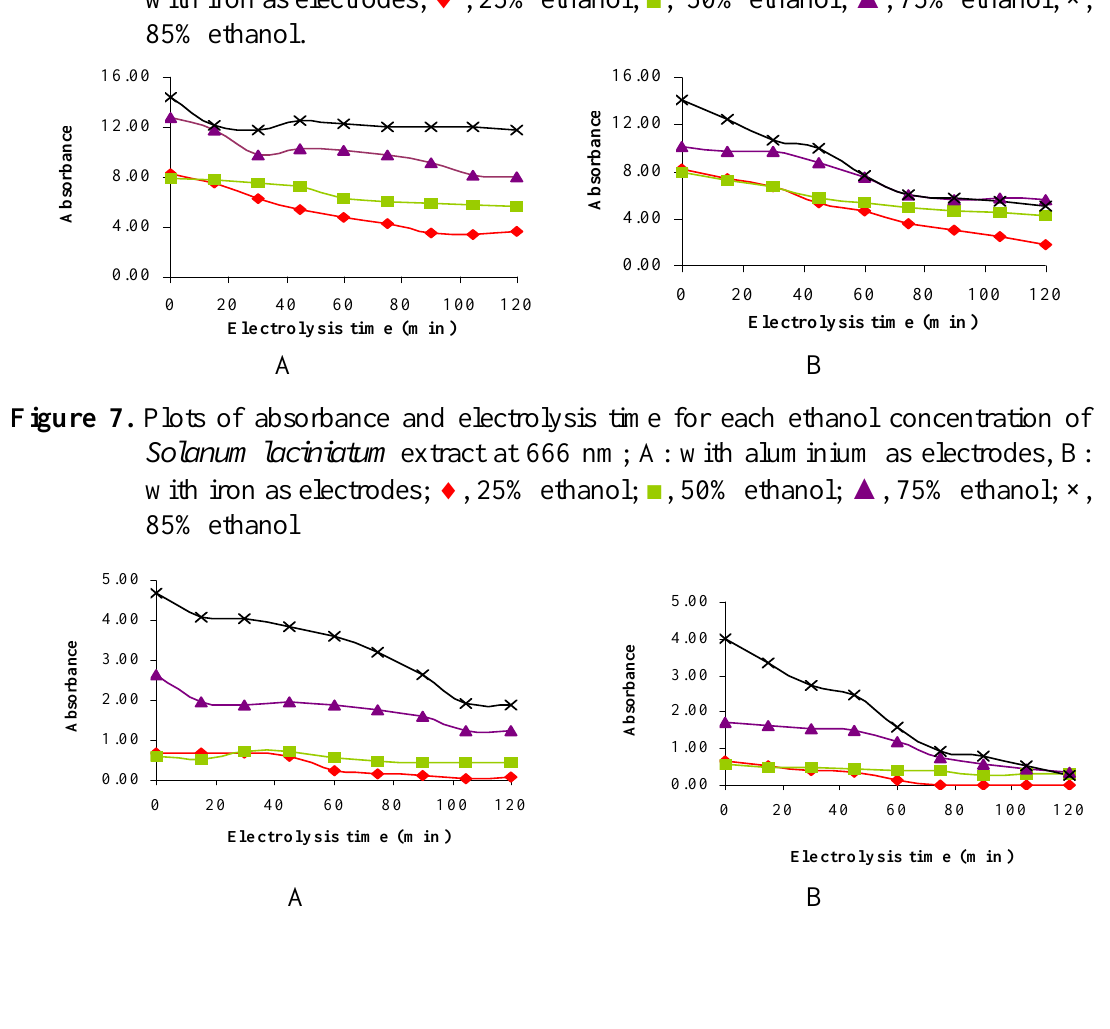
Figure 6. Plots of absorbance and electrolysis time for each ethanol concentration of Solanum laciniatum extract at 408 nm; A: with aluminium as electrodes, B: with iron as electrodes; ♦ , 25% ethanol; ■ , 50% ethanol; ▲ , 75% ethanol; ×, 85% ethanol.